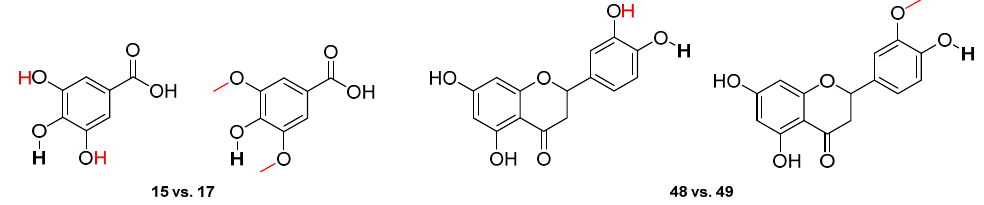
Figure 7. Comparison between gallic acid ( 15 ) and syringic acid ( 17 ) and between eriodictyol ( 48 ) with homoeriodictyol ( 49 ).